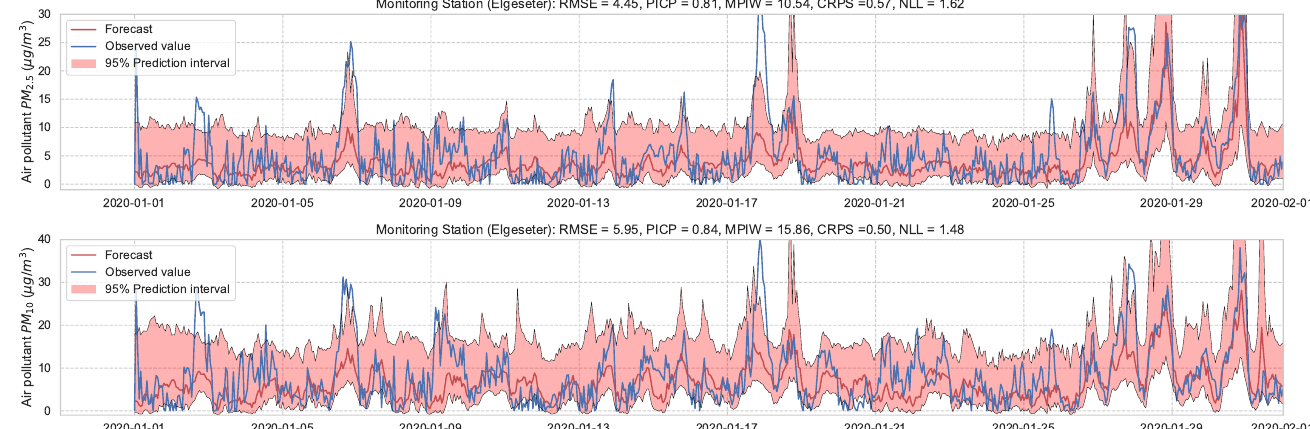
Figure 23. Comparison of uncertainty estimation in PM-value regression when training ( top ) without adversarial training versus ( bottom ) without adversarial training. Using Adversarial training leads to smoother predictive distribution; thus, lower NLL (less overconfident predictions).